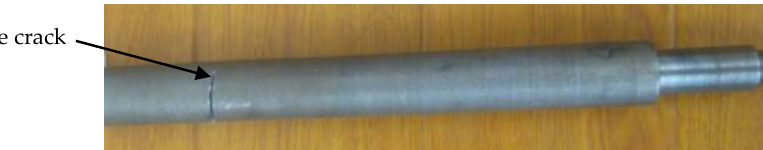
Figure 5. The transverse crack in the non-uniform shaft.